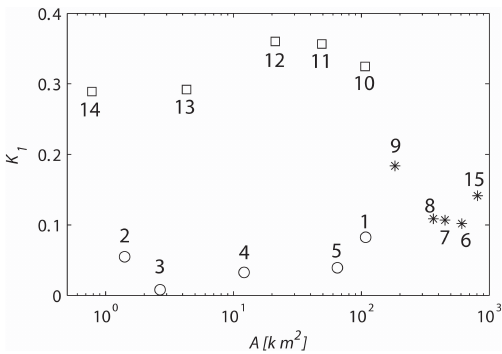
Fig. 9. Relation between parameter K 1 for each sub-basin, and the corresponding sub-basin